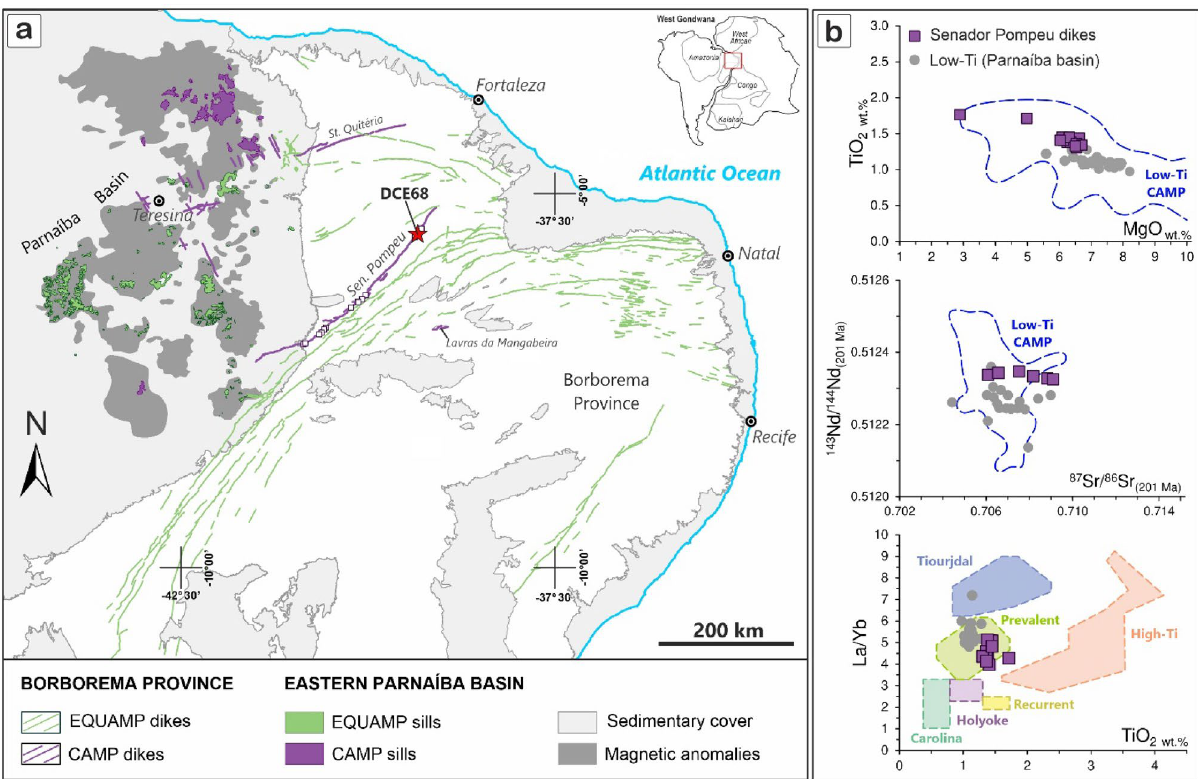
Figure 1. ( a ) Geological map with focus on Mesozoic LIPs in NE South America, the Equatorial Atlantic Magmatic Province 35 —EQUAMP (~ 133.3 Ma, Cretaceous) and the Central Atlantic Magmatic Province 1 — CAMP (~ 201.5 Ma Triassic) (modified from Ref. 18 ). The dated sample (DCE68) of the Senador Pompeu dike swarm is highlighted by a red star. ( b ) Geochemical and isotopic aspects of Senador Pompeu dikes and CAMP Parnaíba basin sills (from Ref. 18 ). Low-Ti fields and magma types from Ref. 45